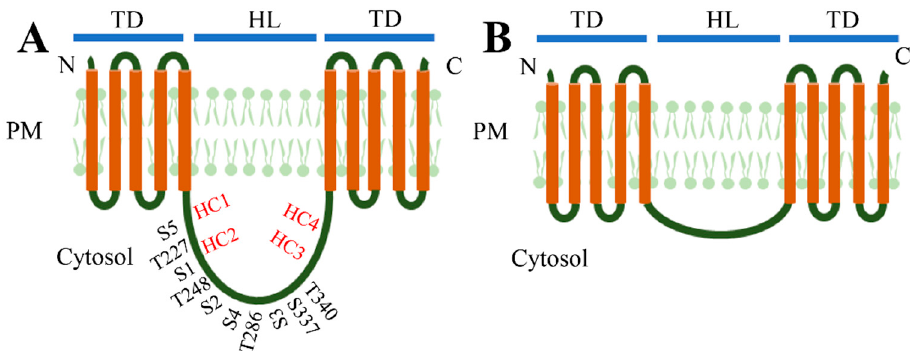
Figure 1. Molecular structures of ( A ) long PIN proteins (PIN1–4, 6 and 7) and ( B ) short PIN proteins (PIN 5 and 8). The PIN proteins harbor a typical central long hydrophilic loop (HL) between amino- and carboxy-terminal ends with five transmembrane domains (TD) spanning on the plasma membrane (PM). The phosphosites on the HL of long PINs are shown [6]. The conserved HC1–HC4 regions in the central loop domain are also indicated according to Bennett et al. [36].